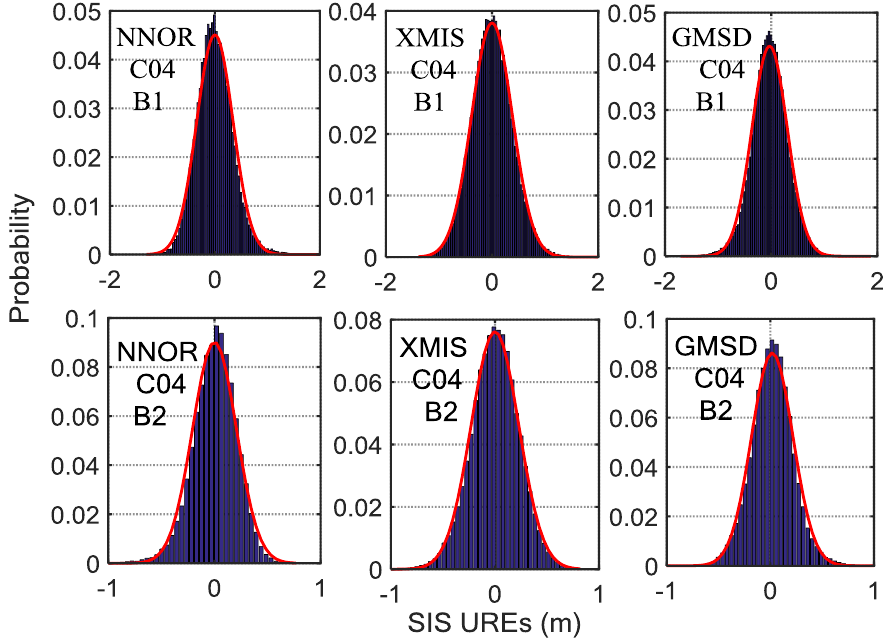
Figure 7. The histograms of C04 SIS UREs (m) after eliminating the trend term covering fourteen experimental days, overlaid with empirical normal probability-density function (PDF) curves (in red). Six subplots, arranged in two rows and three columns, show the results for three tracking stations (left column, NNOR; middle column, XMIS; right column, GMSD) and two frequencies (upper row, B 1 band; bottom row, B 2 band).